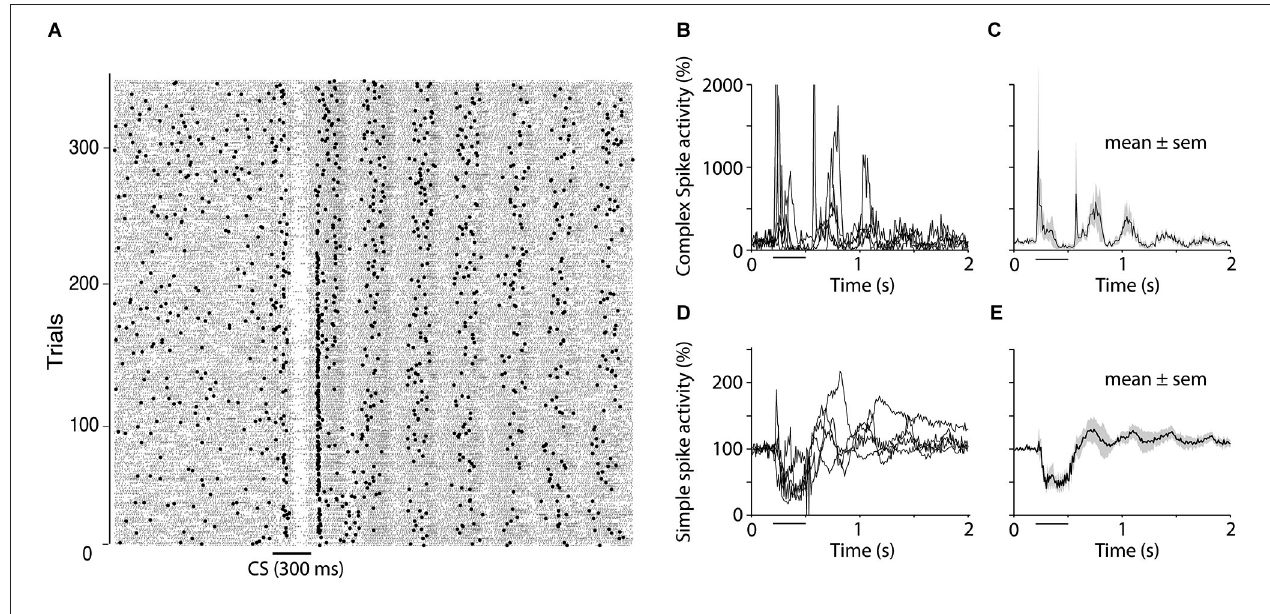
FIGURE 7 | Oscillations of simple and complex spike activity. (A) Raster plot showing simple spikes (small dots) and complex spikes (larger dots) in one Purkinje cell during extinction (CS alone presentations). The plot shows the rebound in both simple and complex spikes that often occurs following the complex spike suppression as well as the subsequent oscillations that were seen